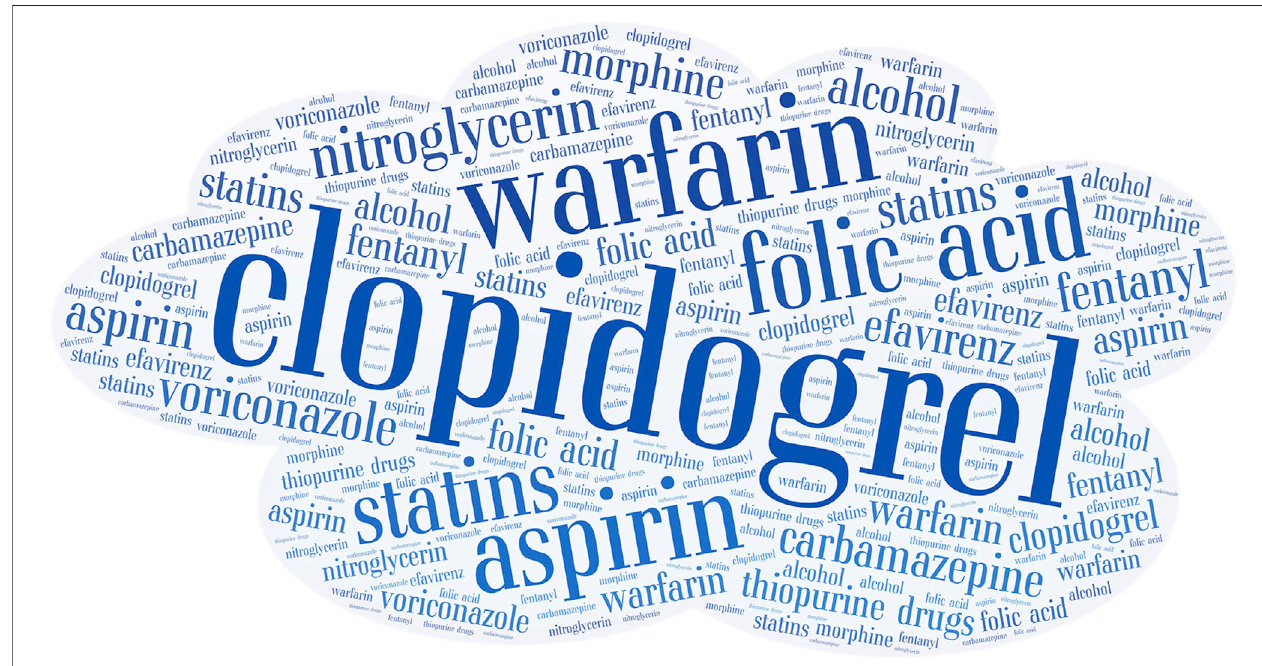
FIGURE 5 | Word cloud depicted the frequency of drugs detected by PGx from the institutions of participants. The size of the print is proportional to the frequency of drug detection.